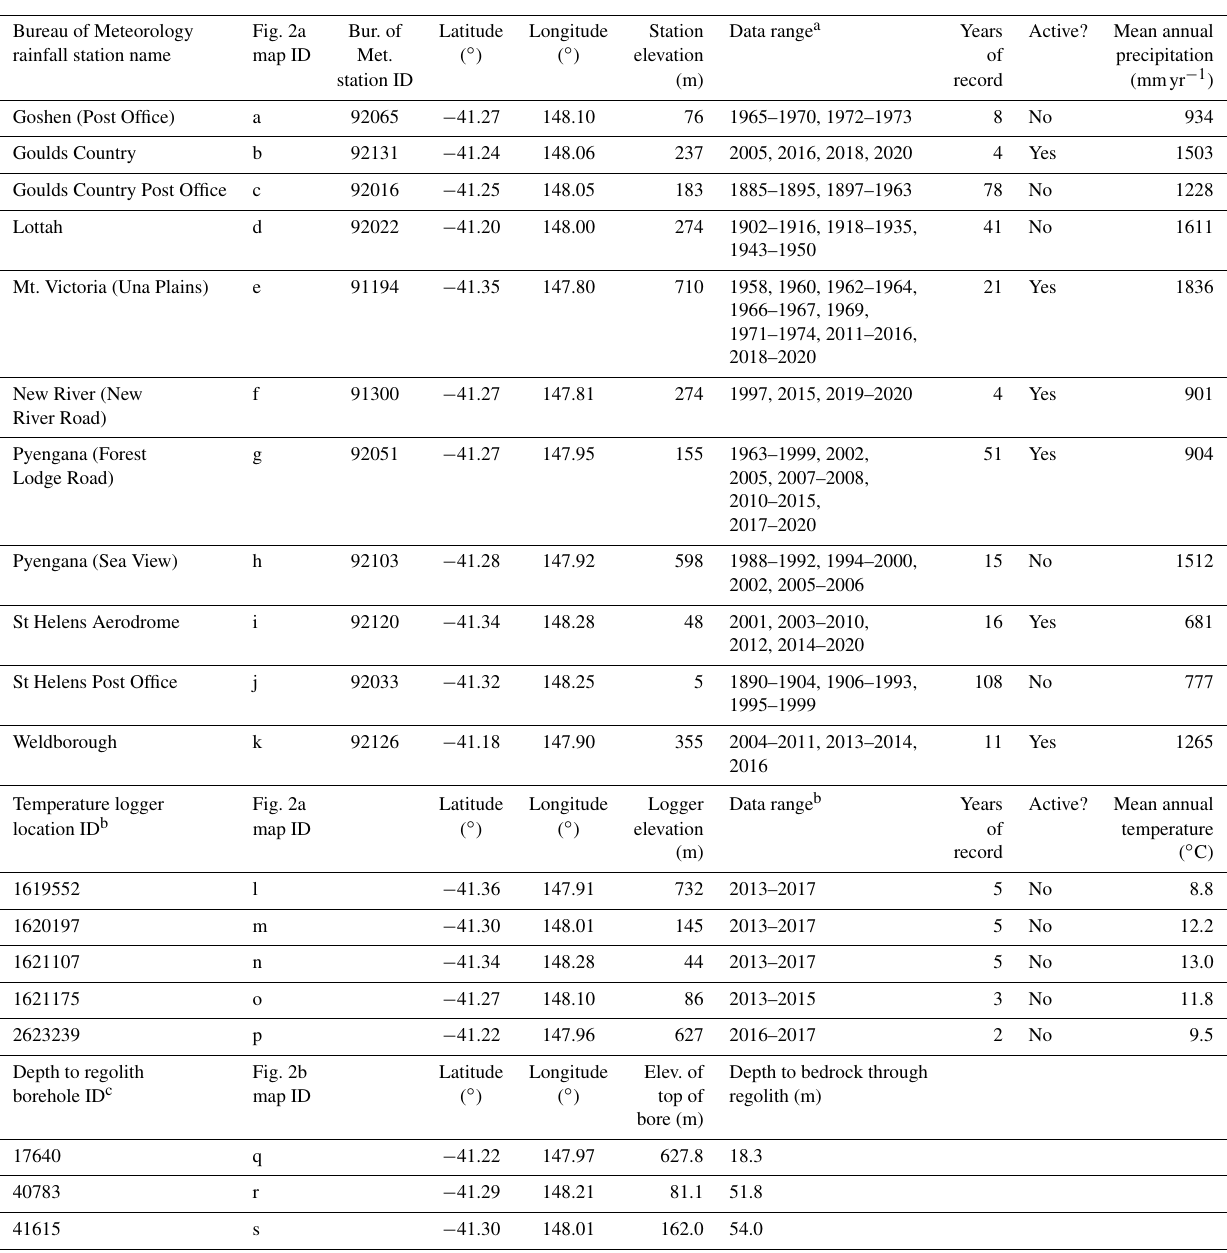
Table 1. Meteorological and bedrock data for the George River basin. Bureau of Meteorology Fig. 2a Bur. of Latitude Longitude Station Data range a Years Active? Mean annual rainfall station name map ID Met.